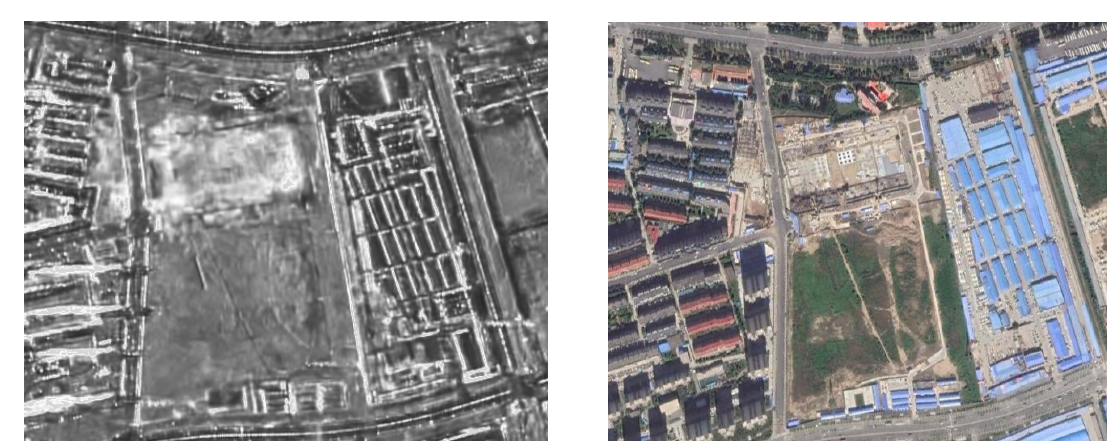
( a ) Data 1: Terra-SAR image acquired in 23 October 2012. After denoising